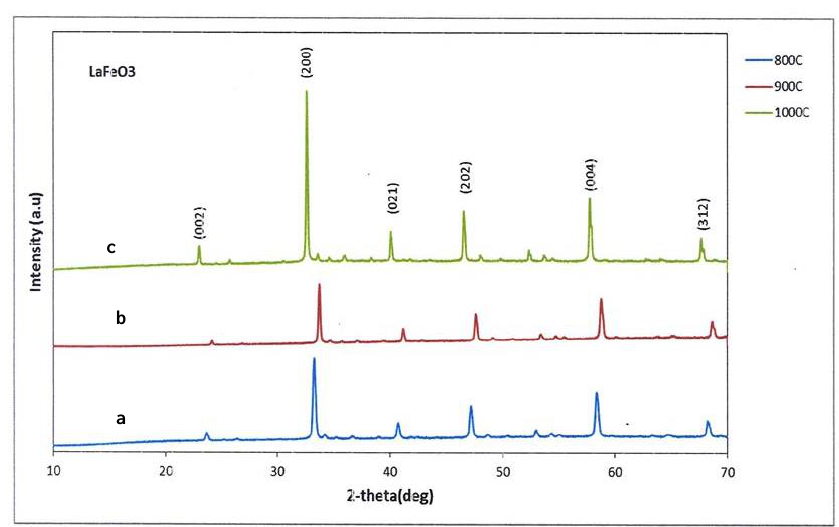
Figure 4. XRD patterns of LaFeO ₃ samples sintered at (a) 800 ˚C, (b) 900 ° C and (c) 1000 ˚C